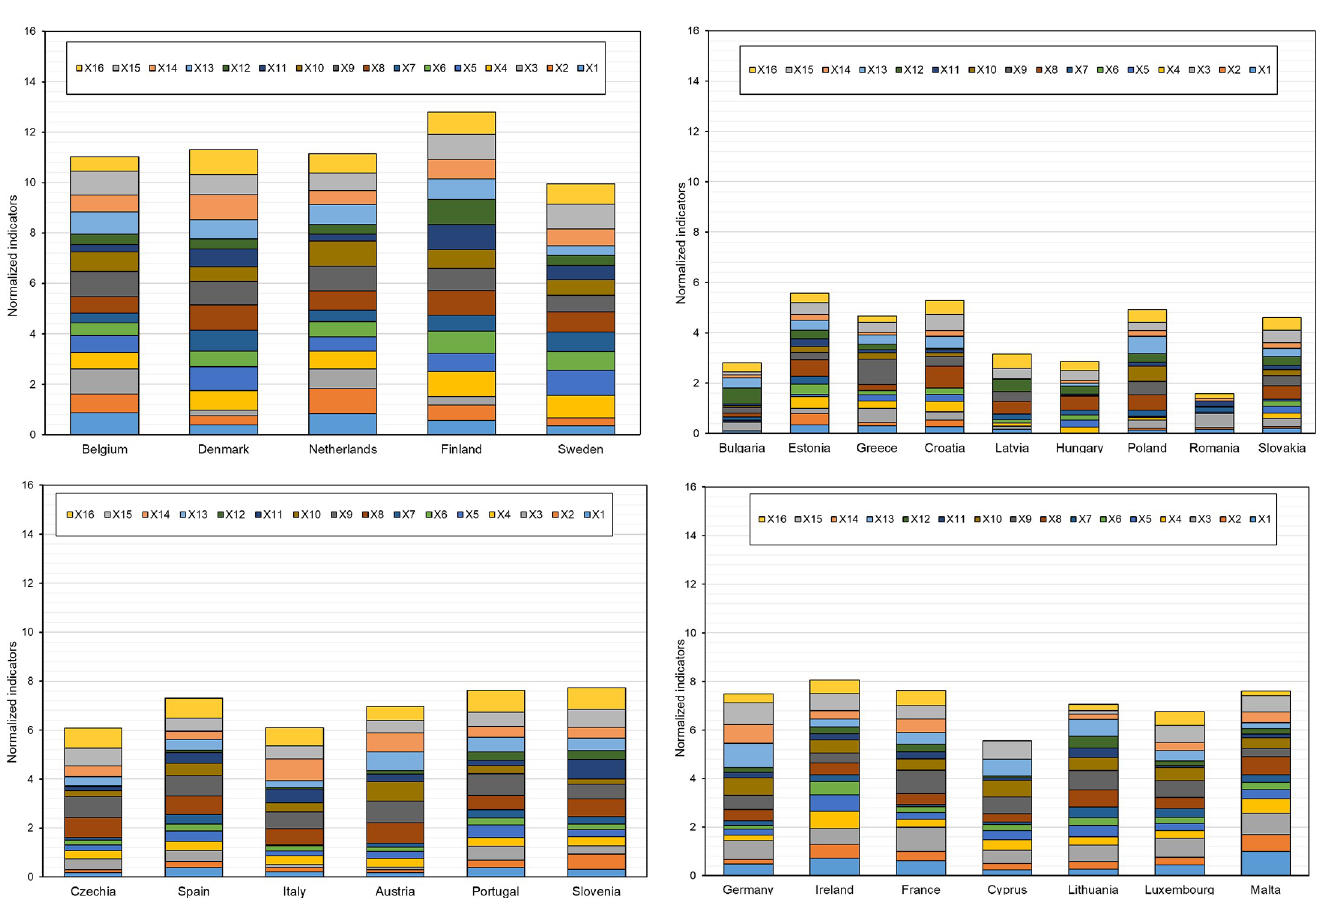
Fig 10. The summary of studied indicators on digitalization and robotization of medium-sized enterprises for EU countries in the designated similar groups (a-cluster 1, b-cluster 2, c-cluster 3, d-cluster 4).